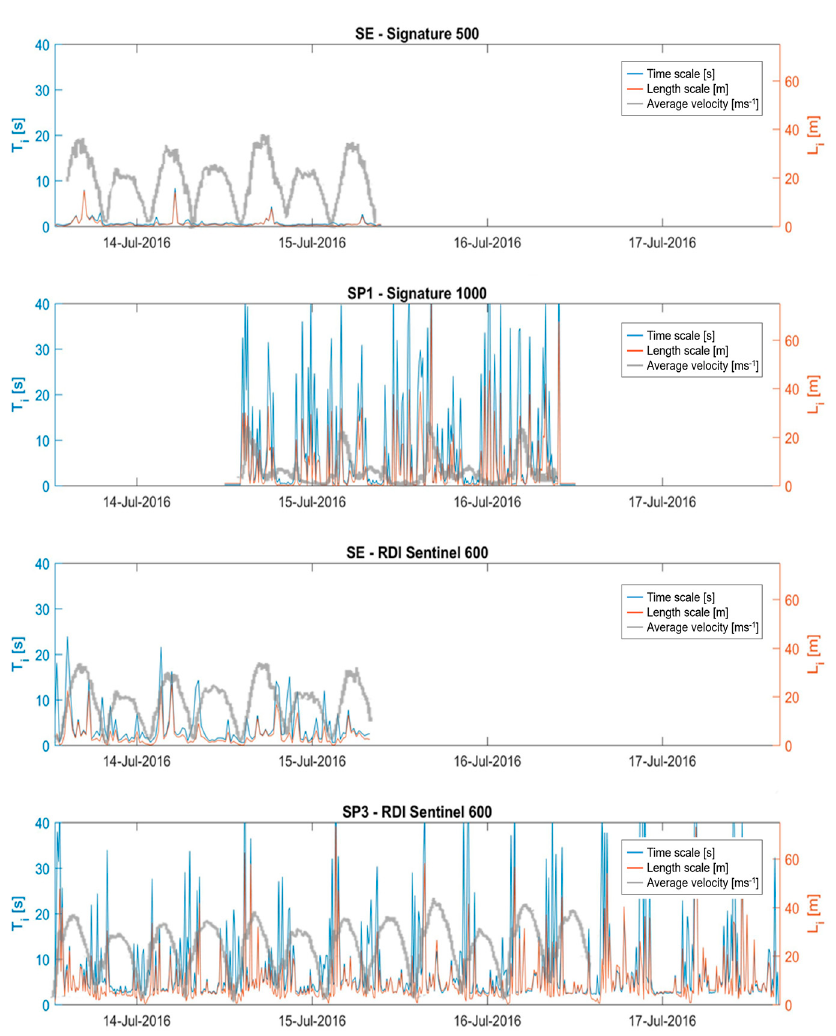
Figure 9. Integral time (blue) and length scales (red) for the streamwise velocity components. Based on measurements 20 m above the seabed for all sensors. The average velocity for each sensor is shown in grey.